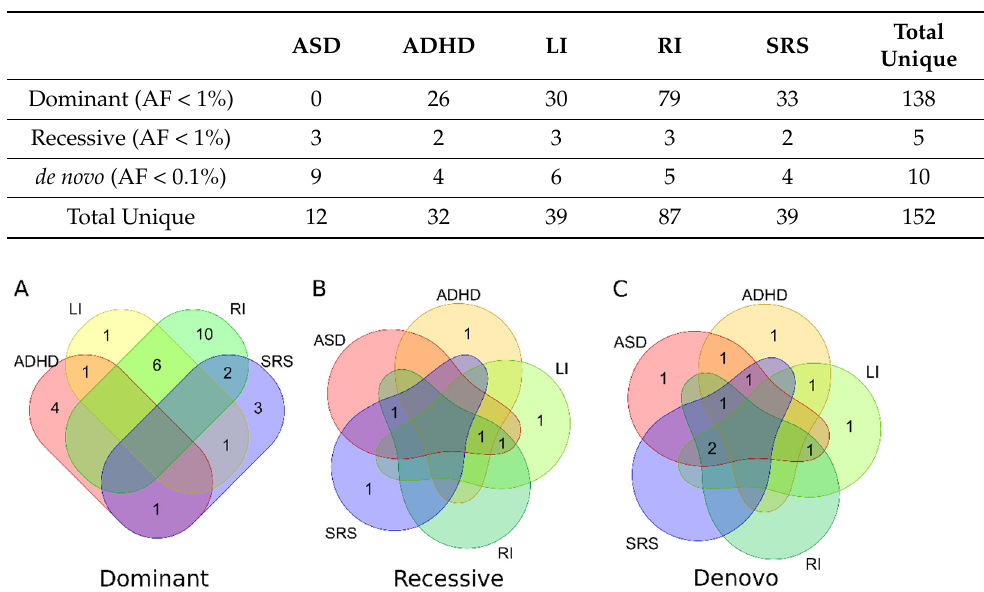
Table 3. Summary of 3 (cid:48) UTR Candidate Genes. Total number of genes found in each phenotype and inheritance pattern.